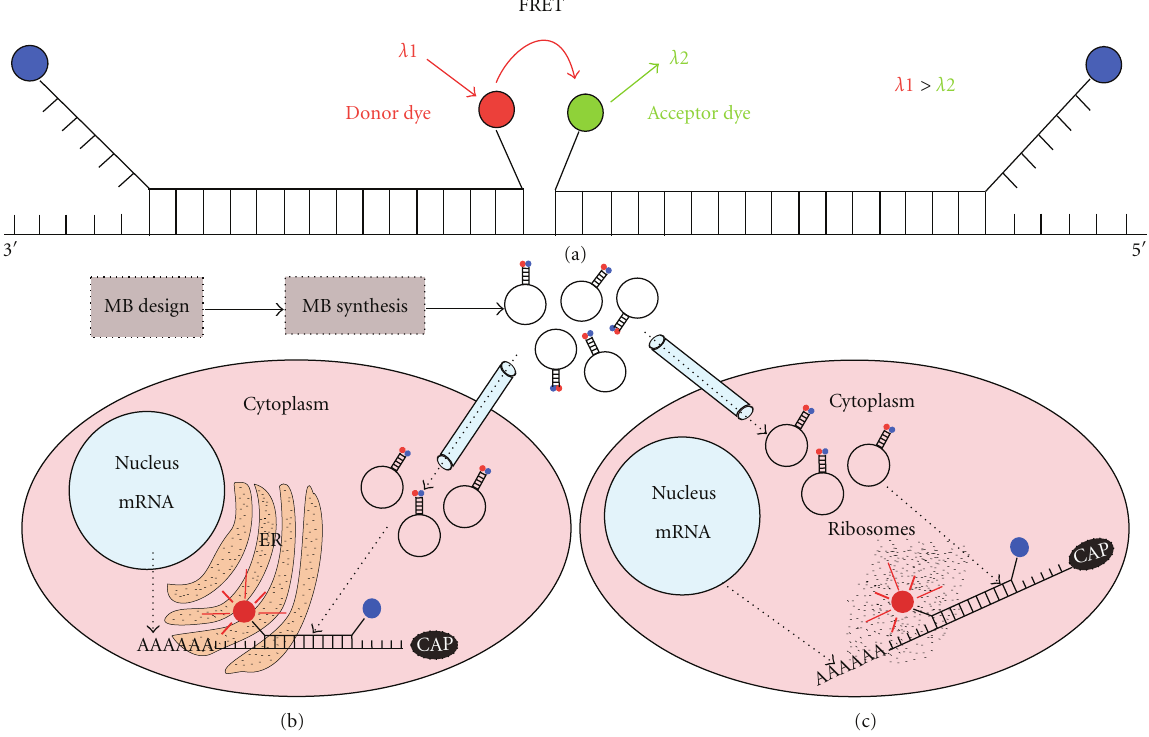
Figure 5: Approaches for RNA visualization in living cells. (a) In order to reduce the possibility of false-positive signals and also increase the specificity, one can design two shared stem MB having a pair reporters compatible with FRET, one to serve like a donor dye (red circle) and the other like a acceptor dye (green circle). With this strategy the sequence to be recognized increases its length and thus the specificity of the assay (observe that one MB needs to have the reporter at the 3 (cid:2) end and the quencher at the 5 (cid:2) end, in a not conventional attachment). After the MB design and synthesis the probe could be delivered using microinjection; in conjunction with other MB or fluorescent dyes could be used to measure RNA distribution at subcellular level. For example it is possible to use a specific fluorescent dye for the endoplasmic reticulum (ER) and also a MB designed to hybridize a given sequence of the ribosome. If a particular mRNA (based on the fluorescence of the MB) colocalizes with the ER dye and ribosome dye it means that this mRNA is translated in ribosomes at ER (b) or if the mRNA signal colocalizes only with the ribosome dye means that the mRNA translation occurs at free ribosomes (c); also it is possible that the mRNA translation takes place at both free and ER associated ribosomes. These are only some examples of the power of using MB in combination with other compartment or structure-specific